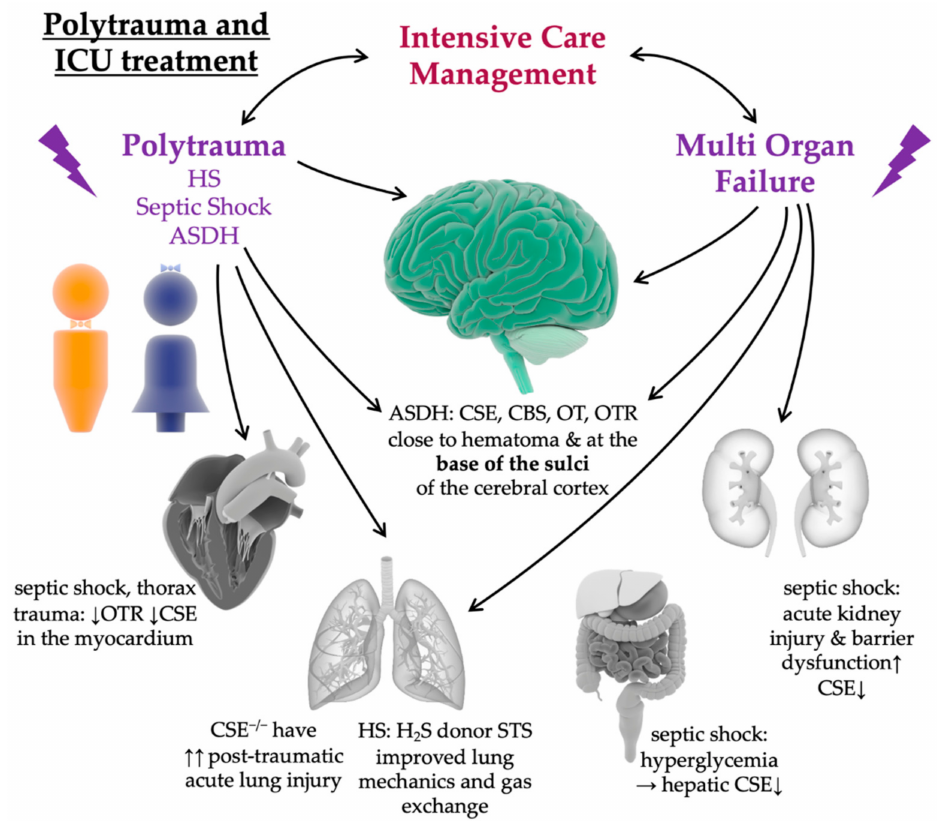
Figure 5. Interaction of Oxytocin/Oxytocin Receptor (OT/OTR) and Hydrogen Sulfide (H 2 S) in Polytrauma. Polytrauma, including hemorrhagic shock (HS), septic shock, and brain injury, such as acute subdural hematoma (ASDH), are associated with a dysregulation of the OT and H 2 S systems in the in the brain and the peripheral organs. Polytrauma can lead to multi-organ fail- ure. Intensive care management is standard in the clinical treatment of polytrauma patients and provides organ-protective support. HS: hemorrhagic shock; ASDH: acute subdural hematoma; STS: sodium thiosulfate; H 2 S: hydrogen sulfide; CSE: cystathionine γ -lyase; CBS: cystathionine- β -synthase; CSE − / − : CSE knock out mice; OT: oxytocin; OTR: oxytocin receptor. ↓ slightly down, ↑ slightly up, ↑↑ strongly up. Illustrations of the male, female, brain, heart, lung, kidneys, gut, and liver were taken from the Library of Science and Medical Illustrations (somersault18:24,